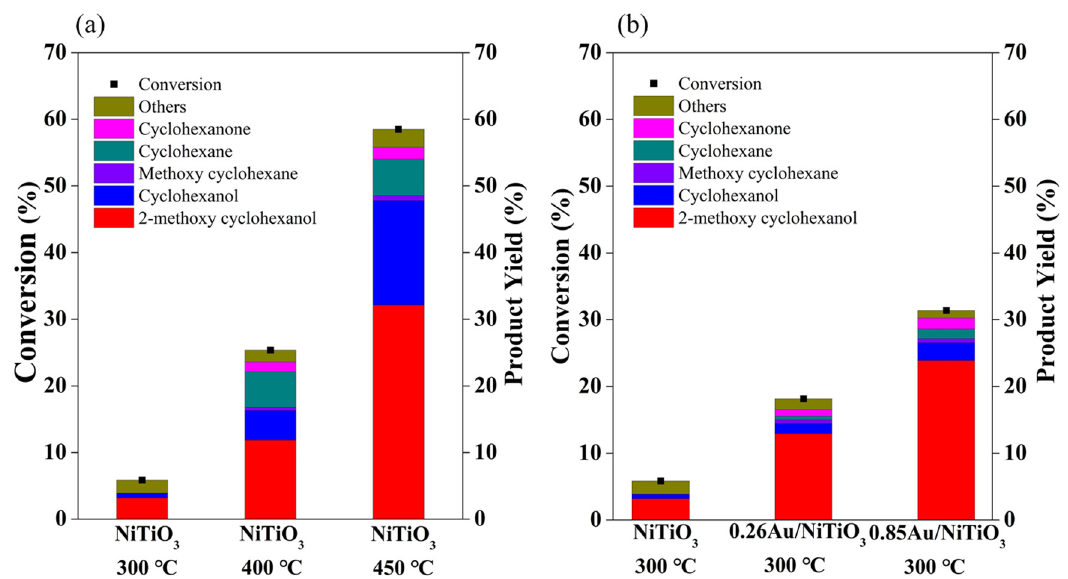
Figure 3. Hydrodeoxygenation of guaiacol obtained under 700 rpm stirring in 3 MPa H 2 at 300 °C for 2 h, over the pure NiTiO 3 pre-treated at 300 °C, 400 °C and 450 °C ( a ) and over the NiTiO 3 and Au/NiTiO 3 catalysts pre-treated at 300 °C ( b ).